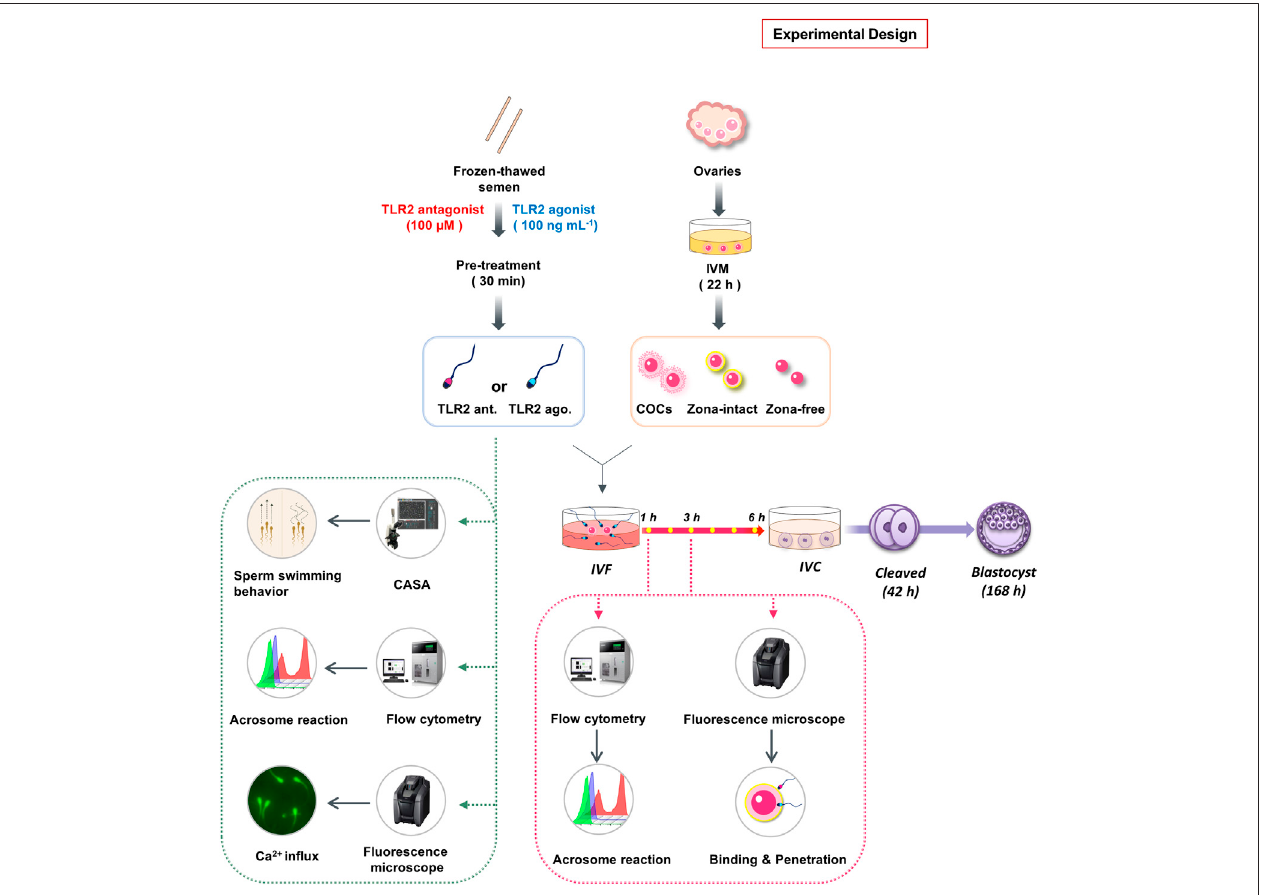
FIGURE 1 | Schematic representation of the study experimental design. Initially, to investigate the potential contribution of sperm TLR2 in sperm-oocyte interaction during in vitro fertilization, TLR2 antagonist (CU-CPT22; 100 µM) or TLR2 agonist (Pam3Cys; 100 ng ml − 1 ) was used for the blockage or activation of TLR2 in frozen-thawed bull sperm for 30 min, respectively. Sperm were then washed, adjusted to a concentration of 0.5 × 10 6 sperm ml − 1 , and co-cultured with matured intact COCs, cumulus-free (zona intact), or zona-free oocytes for 6 h. Cleavage rate and blastocyst rate were evaluated at 42 and 168 h post- insemination respectively. Moreover, the ability of TLR2 antagonist/agonist treated sperm to bind or penetrate ZP and the subsequent induction of AR was evaluatedafter1and 3 hoftheco-cultureusing fl uorescencemicroscopy and fl owcytometry,respectively.Basedon theresults, morefocuswasgiventothedirect impact of blockage/activation of sperm TLR2 on sperm motility parameters, AR, and intracellular Ca 2+ in fl ux using CASA analysis, fl ow cytometry, and fl uorescence microscopy, respectively.